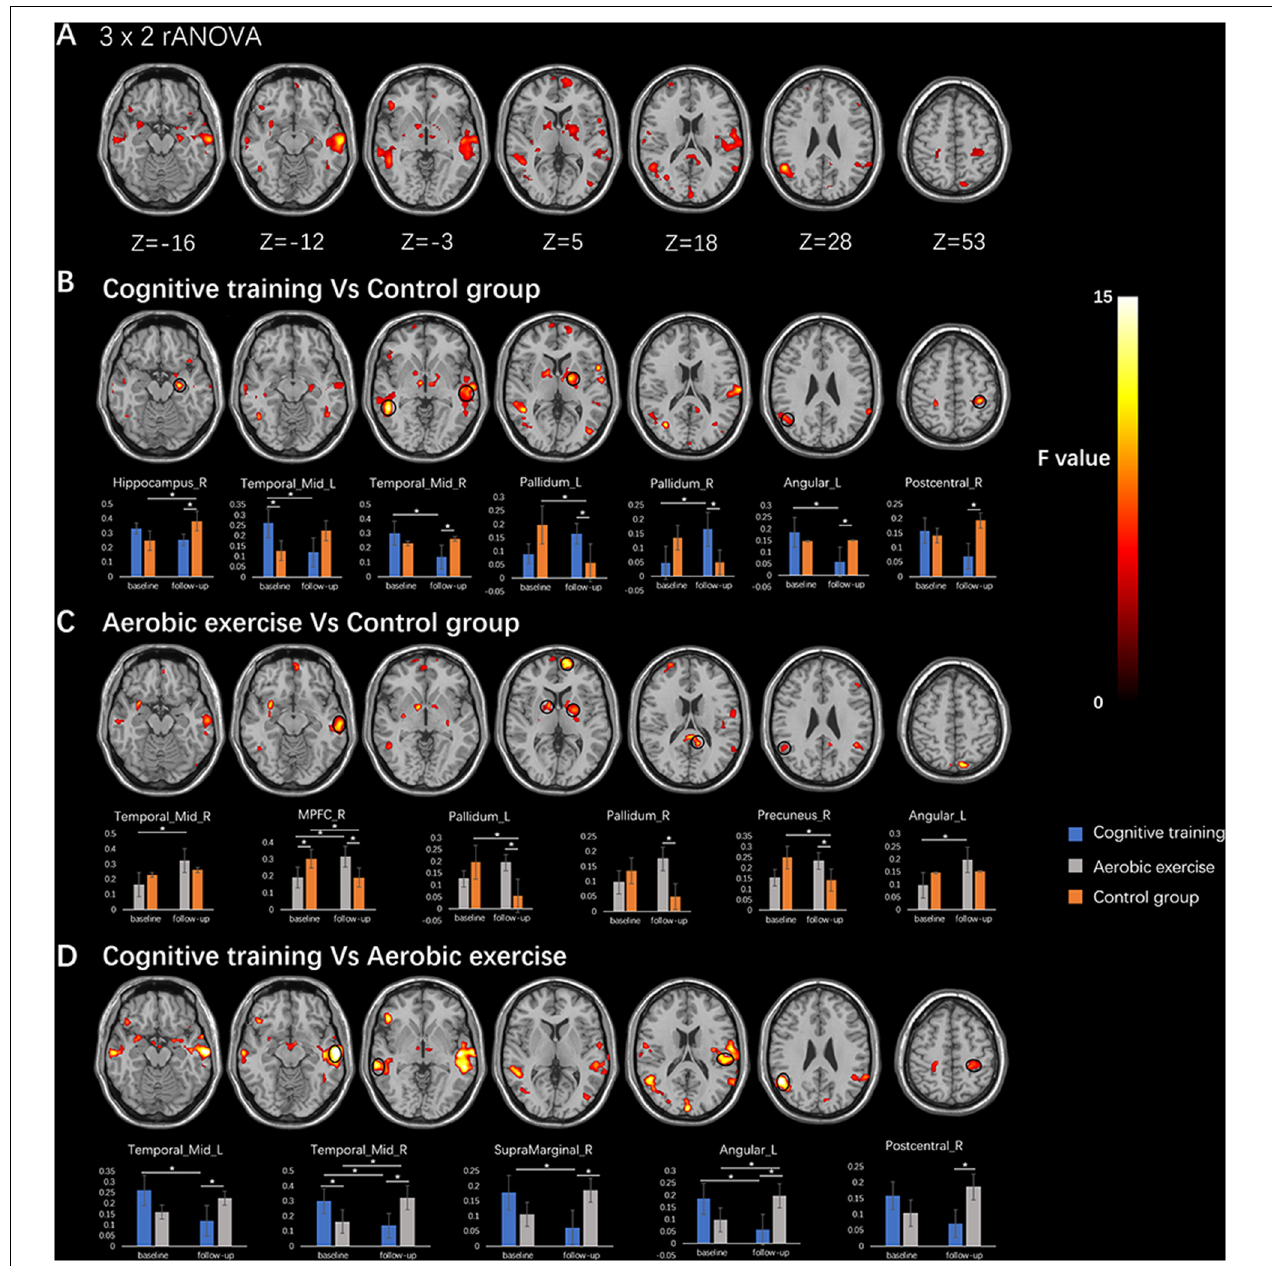
FIGURE 2 | The results of rANCOVA in the entorhinal cortex functional connectivity (EC-FC). (A) The significant interaction effects of 3 × 2 rANCOVA were shown in the first line. (B) The significant interaction results of 2 × 2 rANCOVA among cognitive training and control group were shown in the second line, and the bar chart in the third line showed the results of the post hoc test within group/between-group. (C) The 2 × 2 rANCOVA among aerobic exercise and control group were shown in the fourth line, and the bar chart in the fifth line showed the results of the post hoc test within group/between-group. (D) The 2 × 2 rANCOVA among the cognitive training and aerobic exercise were shown in the sixth line, and the bar chart in the seventh line showed the results of the post hoc test within group/between-group. All interaction results showed p < 0 . 005, and * represented p < 0 . 05. The black circles showed the location of the ROIs.